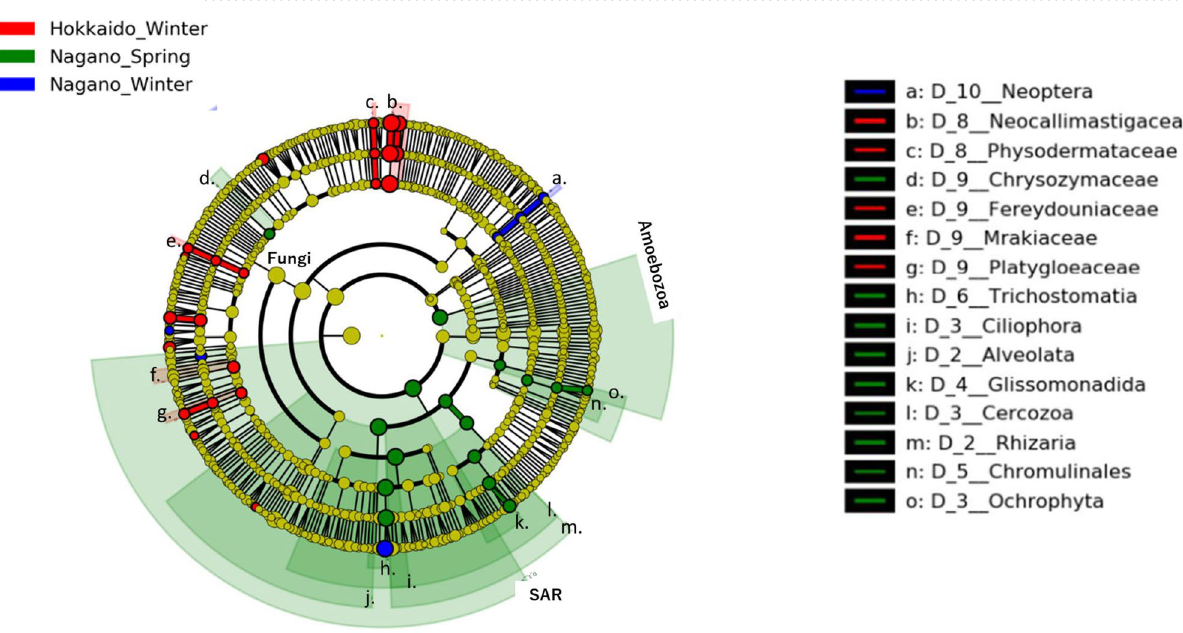
Figure 8. Cladograms of eukaryotic taxa in ruminal eukaryal composition detected by the LEfSe approach. Red, green, and blue indicate significantly different groups (Hokkaido winter, Nagano spring, and Nagano winter, respectively), with the diagram and species classification at the phylum, class, order, family, and genus levels shown from the inside to the outside. Yellow circles represent species with no significant difference. Letters in the cladograms indicate the significantly different taxa in each clade including more than 2 taxa. Eukaryotic taxa excluded chloroplasts and host mitochondria from 18S rRNA amplicon-seq